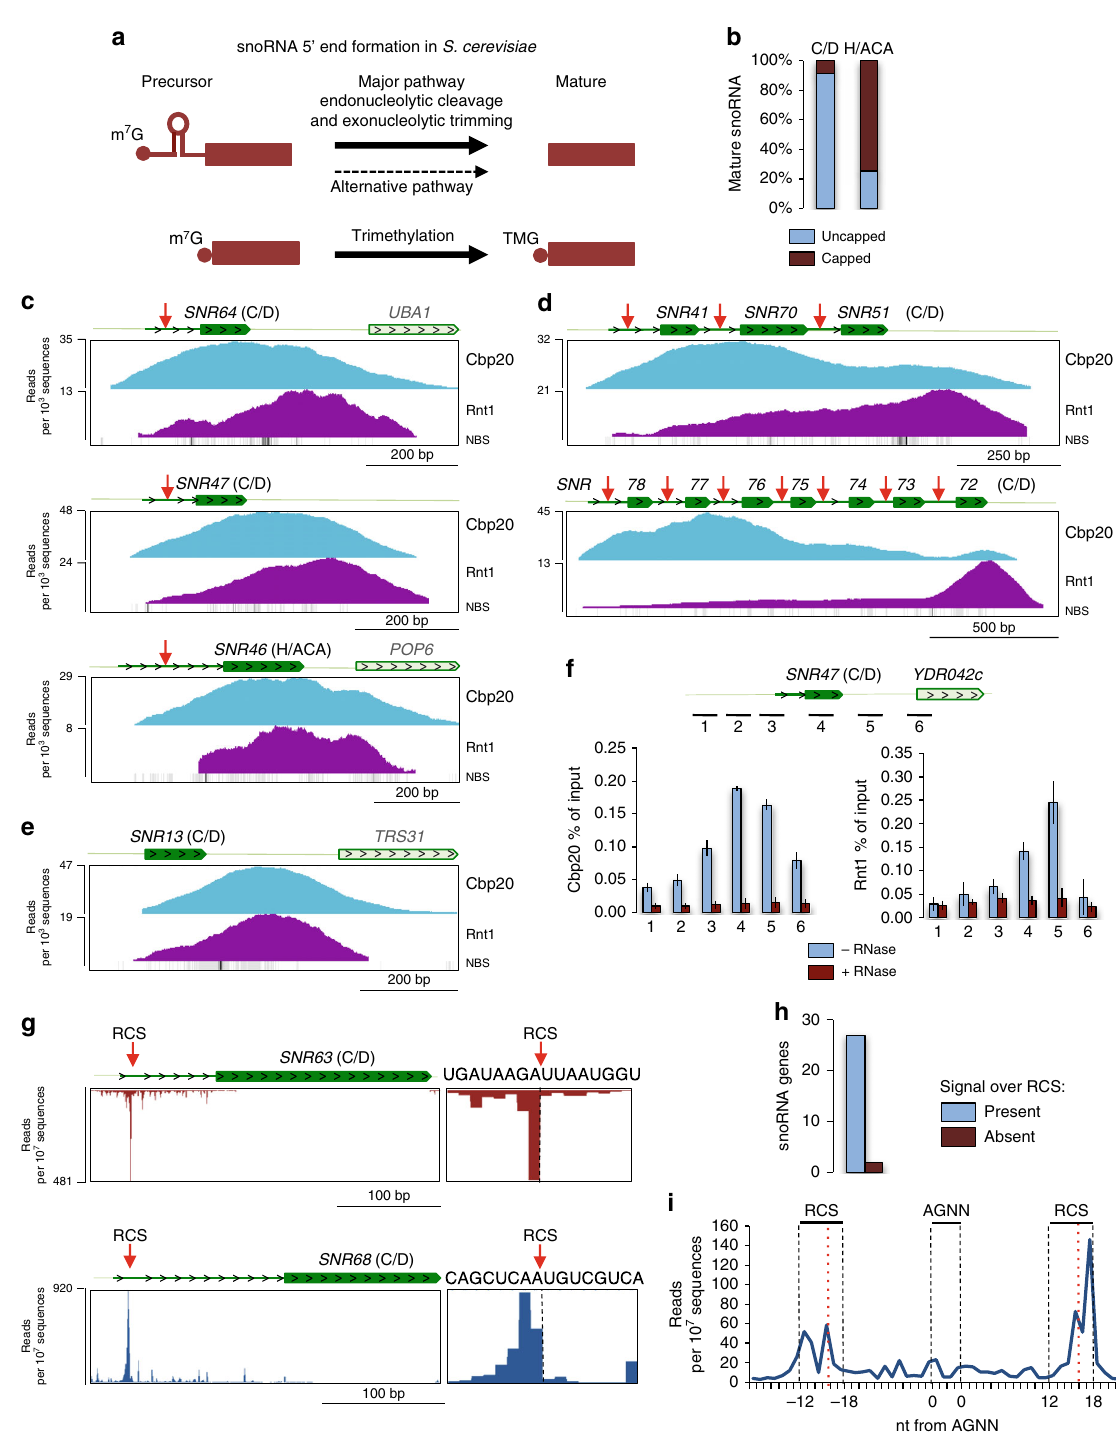
Fig. 1 Co-transcriptional 5 ʹ end processing of snoRNA. a 5 ʹ processing pathways for independently transcribed snoRNA in S. cerevisiae . b Mature independently transcribed snoRNA (including snoRNA located at the 5 ʹ ends of polycistronic TUs) possessing or lacking caps. c - e ChIP-seq analyses of Cbp20 and Rnt1 co-transcriptional recruitment to c snoRNA transcribed as 5 ʹ extended precursors, d polycistronic snoRNA, e snoRNA transcribed without 5 ʹ extension. NNS-binding sites (NBS) are shown below the reads. f ChIP analysis showing RNA-dependent recruitment (RNase sensitive) of Cbp20 and Rnt1 to RD box C/D SNR47 . Average of three independent experiments is shown. Error bars represent standard deviation. g NET-seq signals originating from Rnt1 cleavage sites (RCS) in the pre-snoRNA 5 ʹ extensions. Note that NET-seq signals were bioinformatically depleted over sequences coding mature snoRNA. h The total number of snoRNA (including proximal snoRNA from each polycistron) displaying NET-seq signal within the RCS in the 5 ʹ extension. i Metagene analysis of NET-seq peaks around the AGNN loop in the snoRNA 5 ʹ extension; RCS – Rnt1 cleavage site, the predicted cleavage site is denoted by red vertical dotted line. Green rectangle denotes mature snoRNA while bold green line shows 5 ʹ extension. RCS is marked by red vertical